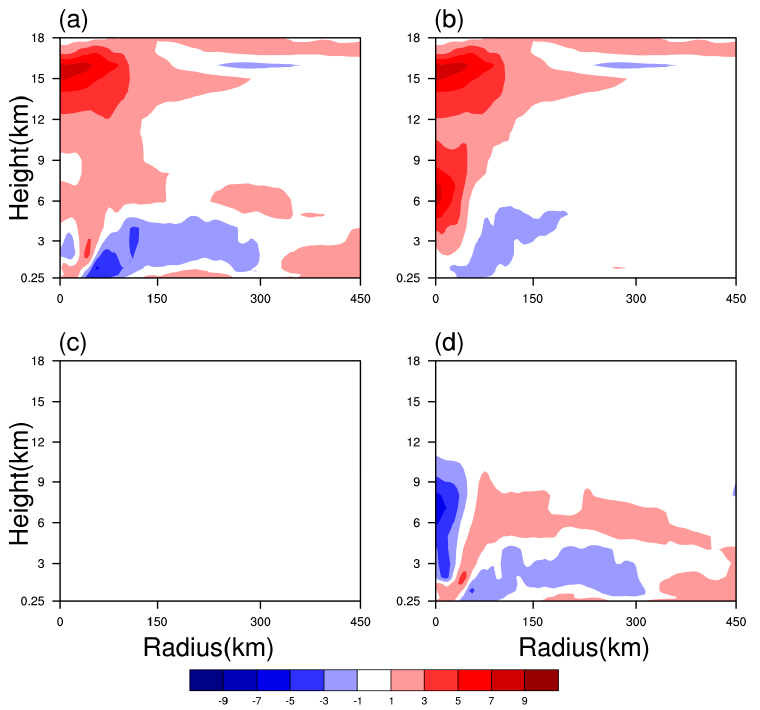
Figure 4. Height-radial cross-sections of the change of ( a ) MSE, ( b ) C p T , ( c ) gz , and ( d ) L v q from hour 24 to hour 48 (units: 10 3 J).